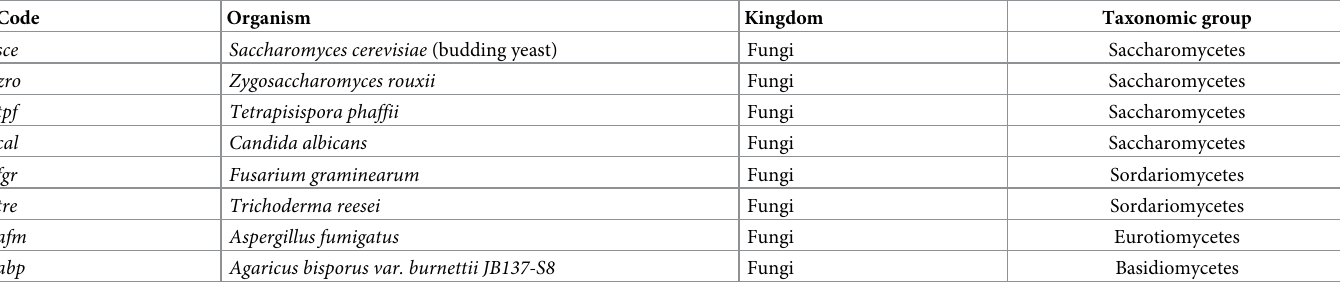
Table 4. Yeasts and Molds considered in the second